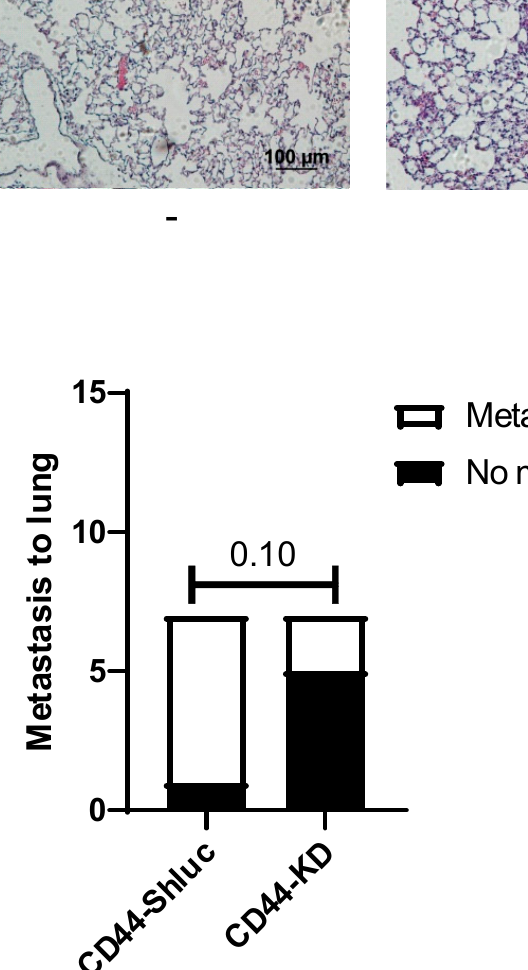
Figure 5. CD44 knockdown decreased lung cancer cell metastasis in tail-vein injection mouse model. ( A ) H & E staining showing representative photos for positive and negative metastatic nodules in the lung. ( B ) Bar graph showing the rate of lung metastasis in control and CD44 knockdown groups.